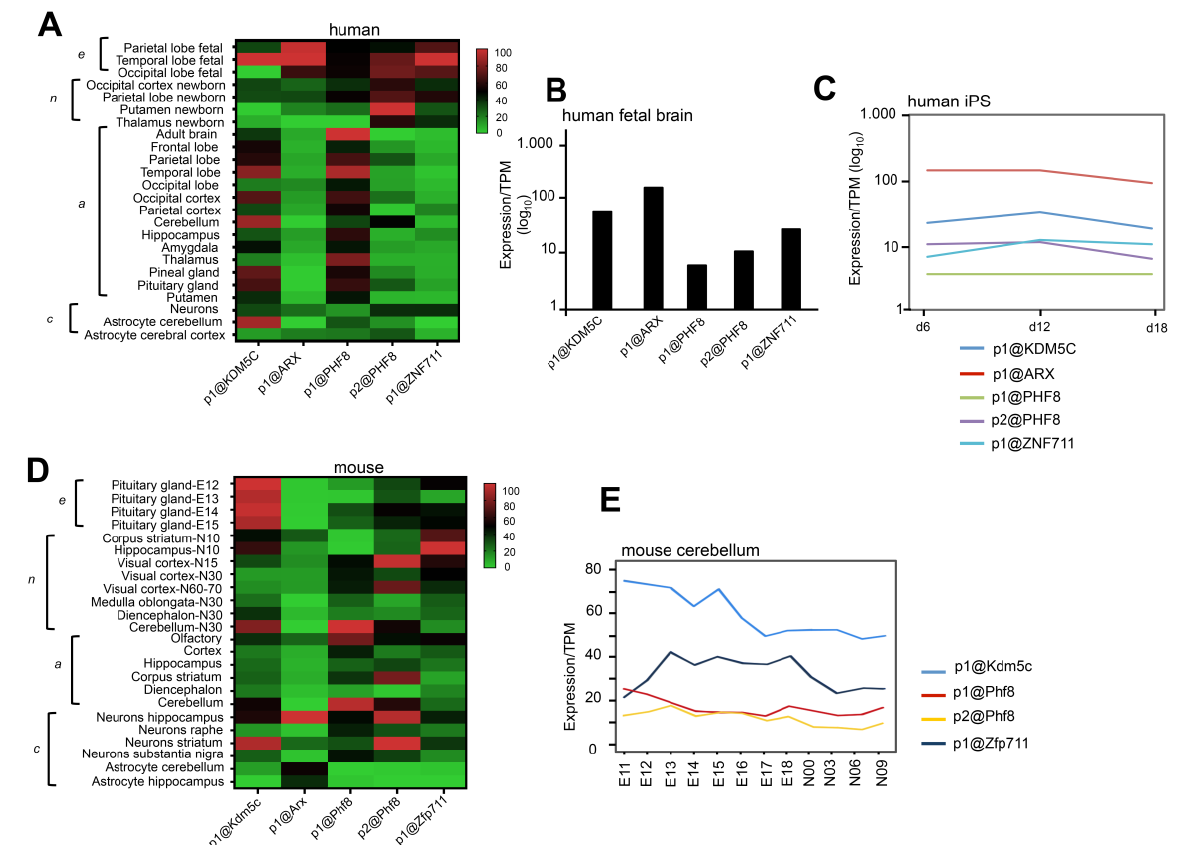
Figure 3. Expression profiles of TSSs in human ( A – C ) and mouse ( D , E ) brain samples. Heat map showing the TPM expression of all promoters in sub-regions of brains and brain-related primary cells in human ( A ). Expression profiles of p1@KDM5C, p1@ARX, p1@PHF8, p2@PHF8, and p1@ZNF711 in human fetal brain ( B ) and in human iPS differentiated to neuron ( C ), (day 6 = neuro-ectodermal cells; day 12 = neural stem cells; day 18 = early neuronal progenitors). The expression of each CAGE promoter is reported as TPM on the y -axis. Heatmap showing the TPM expression of all promoters in sub-regions of brains and brain-related primary cells in mice ( D ). Expression profiles of p1@Kdm5c, p1@Arx, p1@Phf8, p2@Phf8, and p1@Zfp711 in mouse cerebellum ( E ). Heatmap’s data are normalized and are reported as percentages with respect to the largest value in each data set. Data are available at https://fantom.gsc.riken.jp (accessed on 1 May